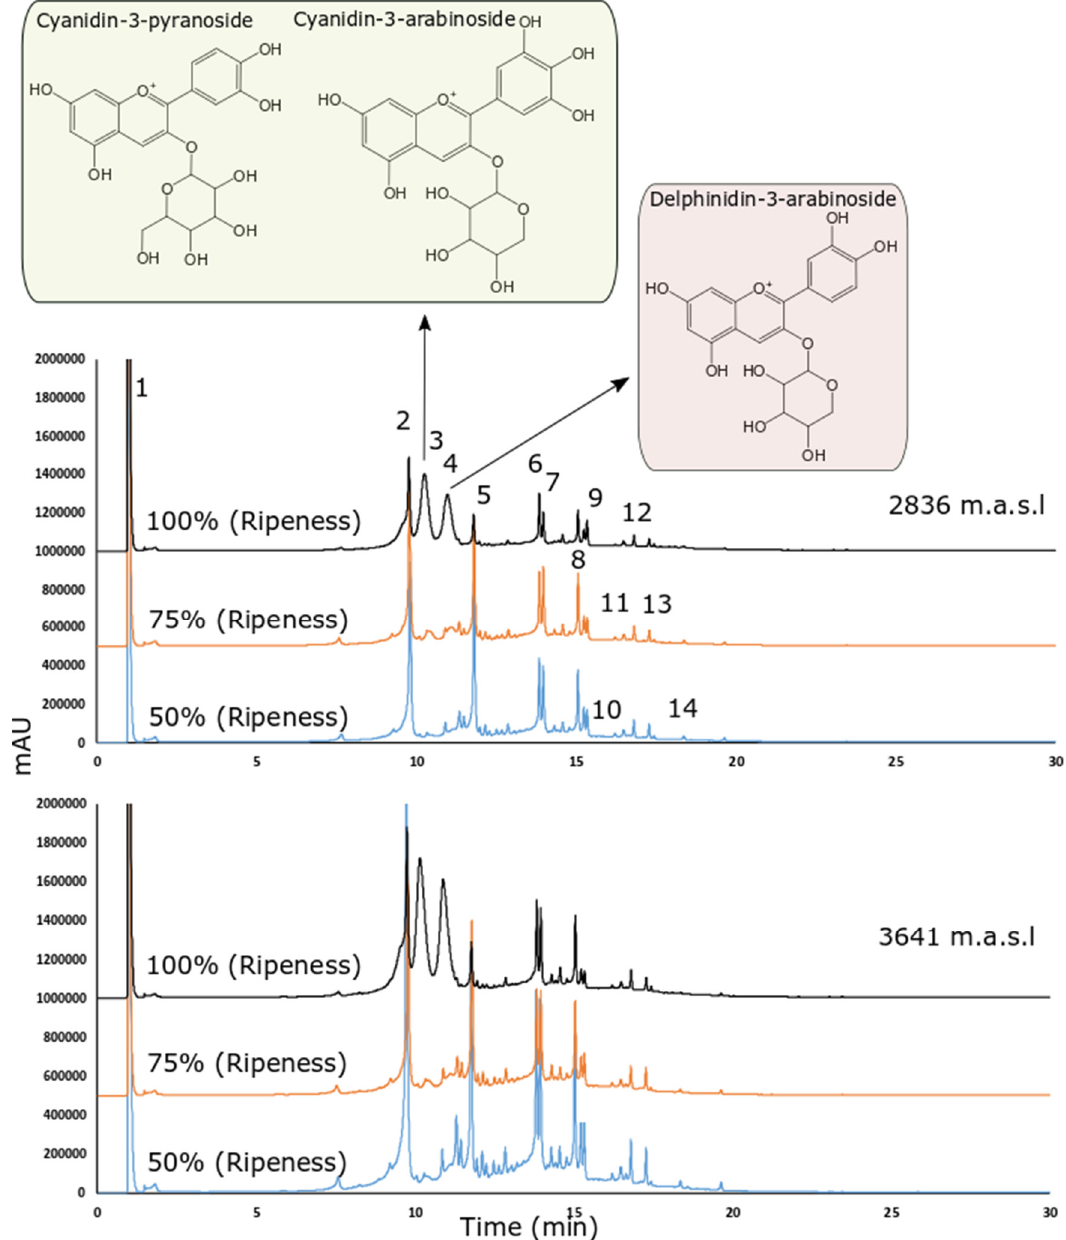
Figure 2. HPLC-DAD chromatogram recorded at 370 nm of the wild Andean blueberry ( V. floribundum Kunth) fruit extract across different altitudes and ripening stages (blue: 50% ripeness, orange: 75% ripeness and black: 100% ripeness).